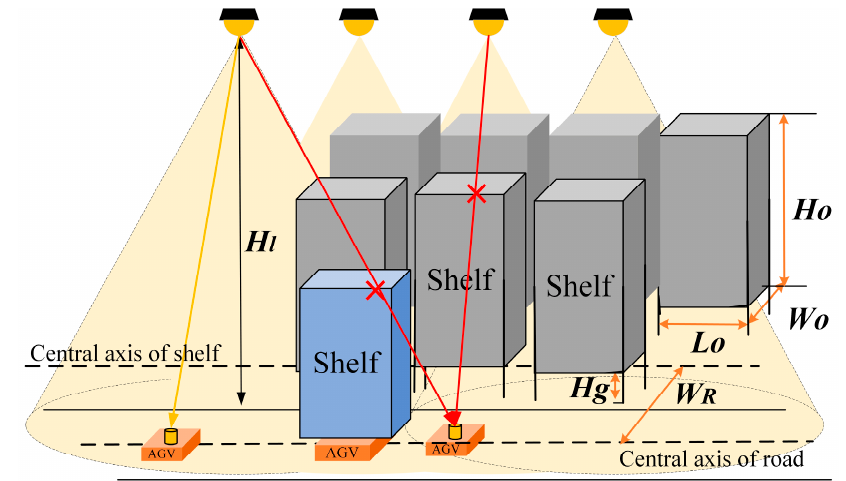
Figure 1. Blocking source of VLC link between AGV and AP.